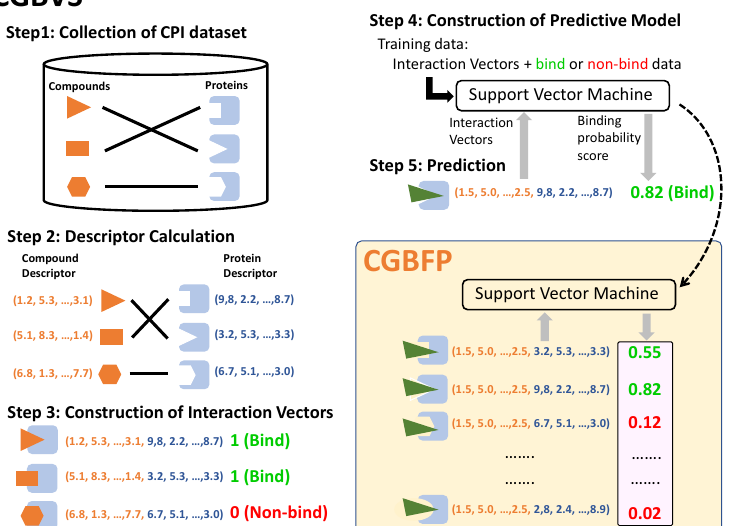
Figure 1. Workflow of CGBVS and CGBFP generation. The CGBVS section illustrates construction of predictive models for compound-protein interactions (CPIs) via Step 1 to Step 5. The CGBFP section shows the generation of CGBFP using CGBVS predictive models (Support Vector Machine). Values within the pink box represent